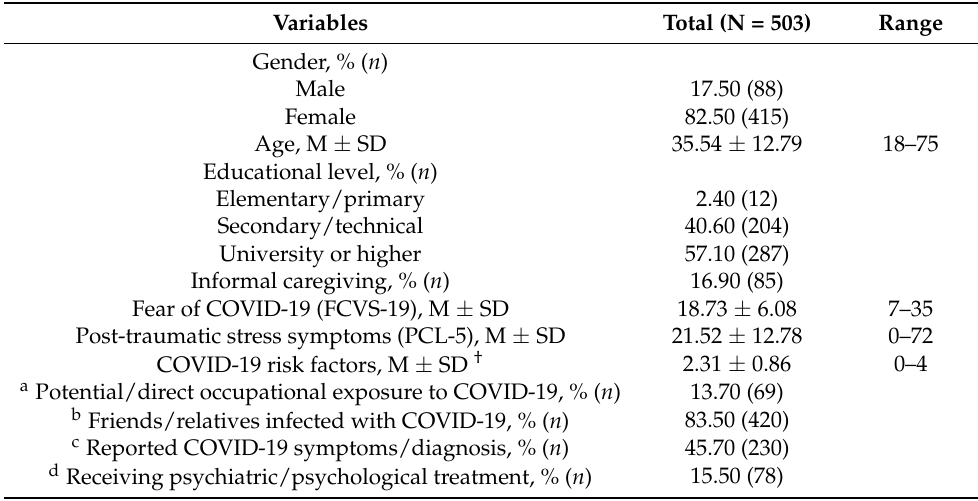
Table 1. Demographic, psychological, and COVID-19 related characteristics of the